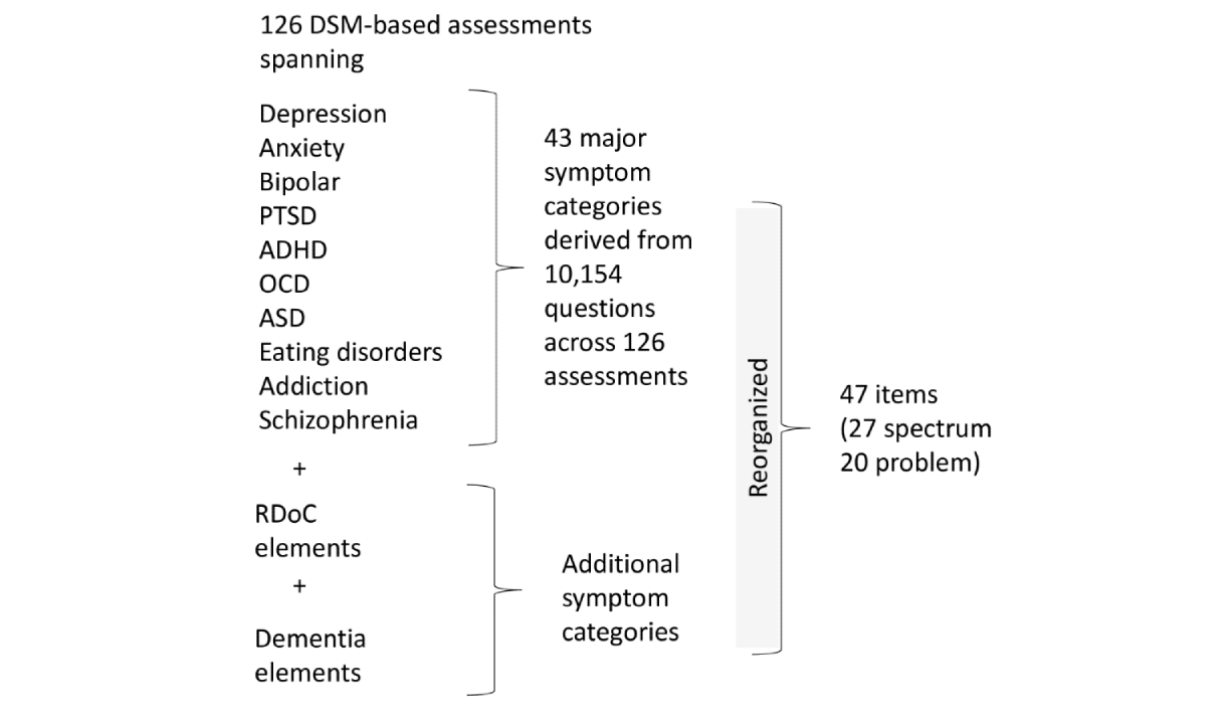
Figure 1. Diagram illustrating the method of development of the Mental Health Quotient. A total of 126 commonly used psychiatric assessment tools covering 10 disorders (as well as those taking a cross-disorder approach) were reviewed and consolidated into 43 symptom categories. These categories, together with additional symptom categories taken from a review of Research Domain Criteria constructs as well as dementia elements, were reorganized into a final set of 47 items that were divided into spectrum and problem items for inclusion in the Mental Health Quotient. ADHD: attention-deficit/hyperactivity disorder; ASD: autism spectrum disorder; DSM: Diagnostic and Statistical Manual of Mental Disorders; OCD: obsessive-compulsive disorder; PTSD: post-traumatic stress disorder; RDoC: Research Domain